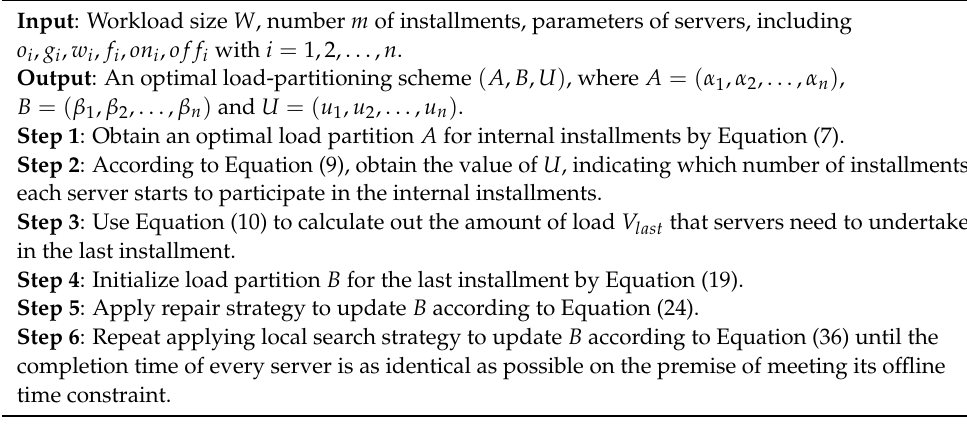
Algorithm 1 first finds an optimal solution to the internal installments through